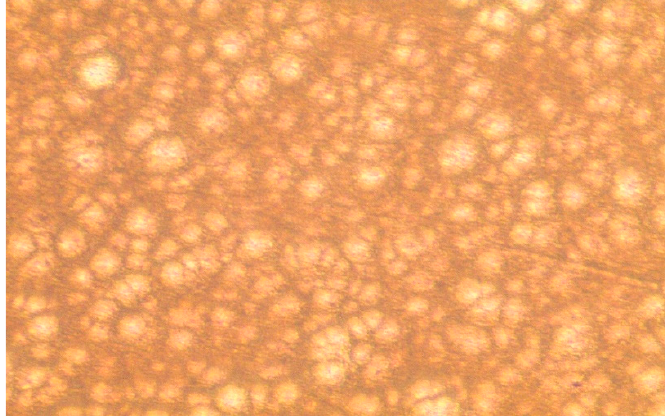
Figure 8. Light microscopy picture of the optimized drug in the adhesive patch.